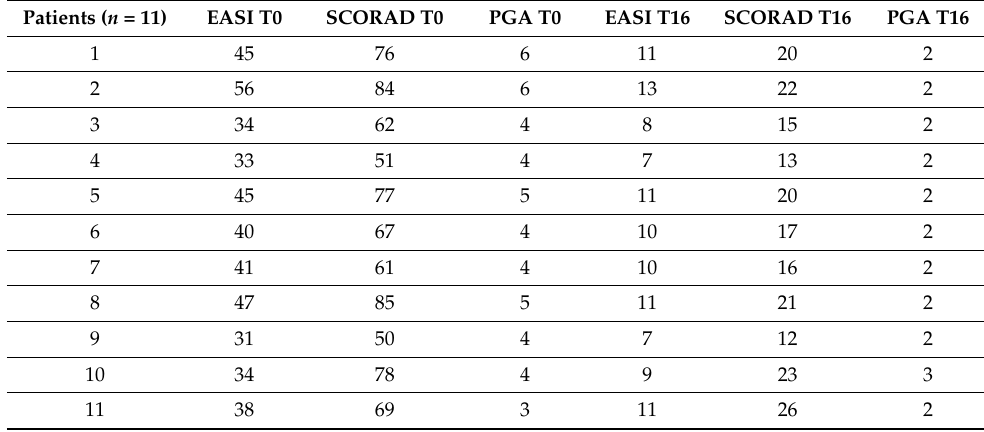
Table 1. Absolute values of clinometric indexes in AD patients at baseline (T0) and after 16 weeks of treatment with Dupilumab (T16). (EASI: “Eczema Area and Severity Index”; PGA: “Physician Global Assessment”; SCORAD: “SCORing Atopic